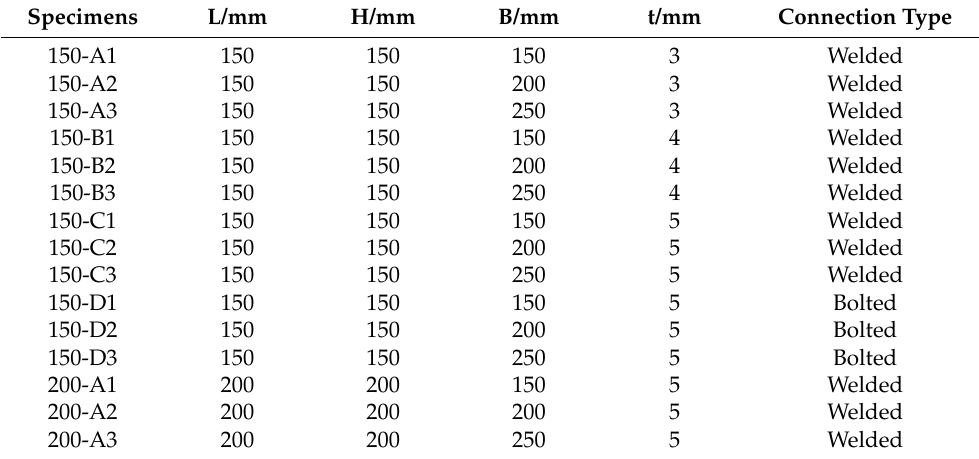
Table 1. Design parameters of the specimens.